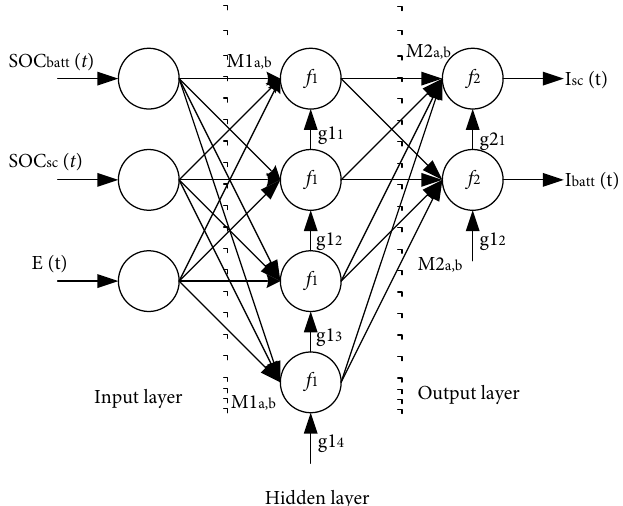
Figure 4: The architecture of a neural